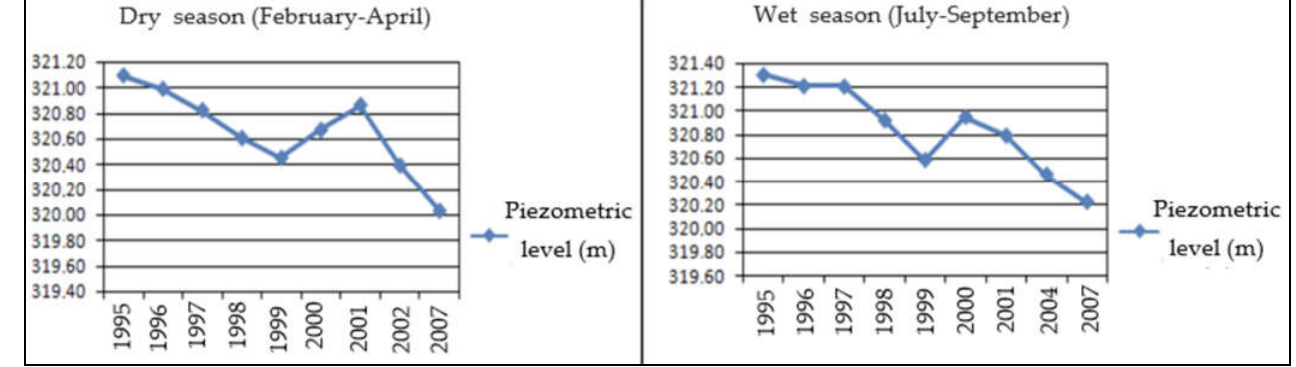
Figure 3. Piezometric record between 1995 and 2007 of the Kou and Taoudéni basins [25]. The groundwater flow in this sandstone aquifer is towards the basement rock aquifer [23]. Concerning the basement rock, they form discontinuous aquifers, i.e., fractured aq- uifers. These fractured basement rock aquifers are sometimes underlying and associated with weathered zones. These weathered zones are 10 m to 80 m thickness and represent the upper part of the basement rock aquifer. The water table in this upper part may be between 5 and 30 m below the ground surface. For fractured basement rock aquifers, their thickness can reach 10 to 80 m and the water table can be between 20 and 60 m below the ground surface [26]. Recharge by rainwater infiltration is generally low [26]. The basin has only one main and temporary river which rises in the commune of Kankalaba, at an alti- tude of 600 m, and flows from north to south for 28.15 km before joining Loumana down- stream at 250 m altitude (Figure 4).